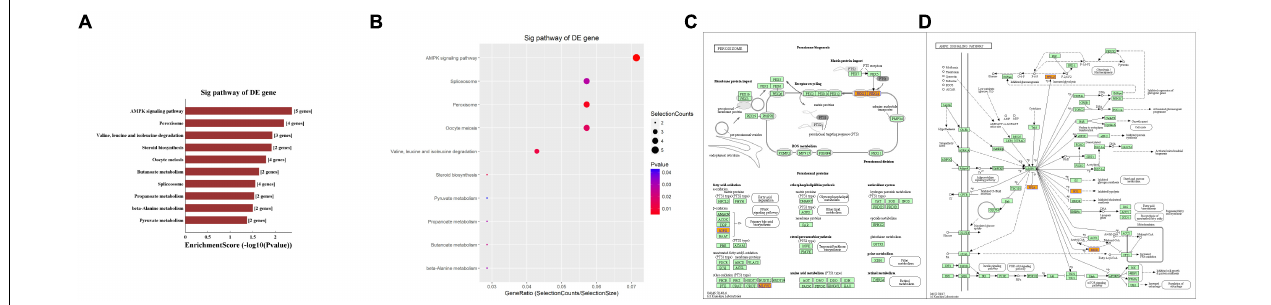
FIGURE 8 | KEGG pathway analysis of target mRNAs regulated by the five candidate circRNAs. (A) The bar plot shows the top 10 enrichment score values of the significantly enriched pathway. (B) The dot plot shows the gene ratio values of the top 10 most significantly enriched pathways. (C) The AMP-activated protein kinase (AMPK) signaling pathway and (D) the peroxisome related pathway are shown. Yellow marked nodes are associated with downregulated genes, orange marked nodes are associated with upregulated or only whole dataset genes, and green nodes have no